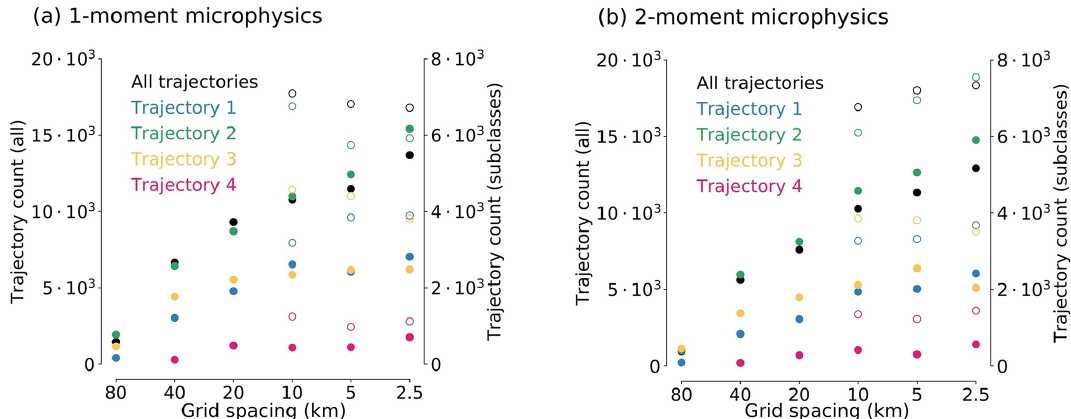
Figure 5. (a) Number of WCB trajectories as a function of horizontal grid spacing. The total number of trajectories is shown in black, with values given by the left y axis. The number of trajectories in the four subclasses is shown in colors, with values given by the right y axis. Filled and open markers correspond to parameterized and explicit convection, respectively. Panel (a) is for one-moment microphysics and panel (b) for two-moment